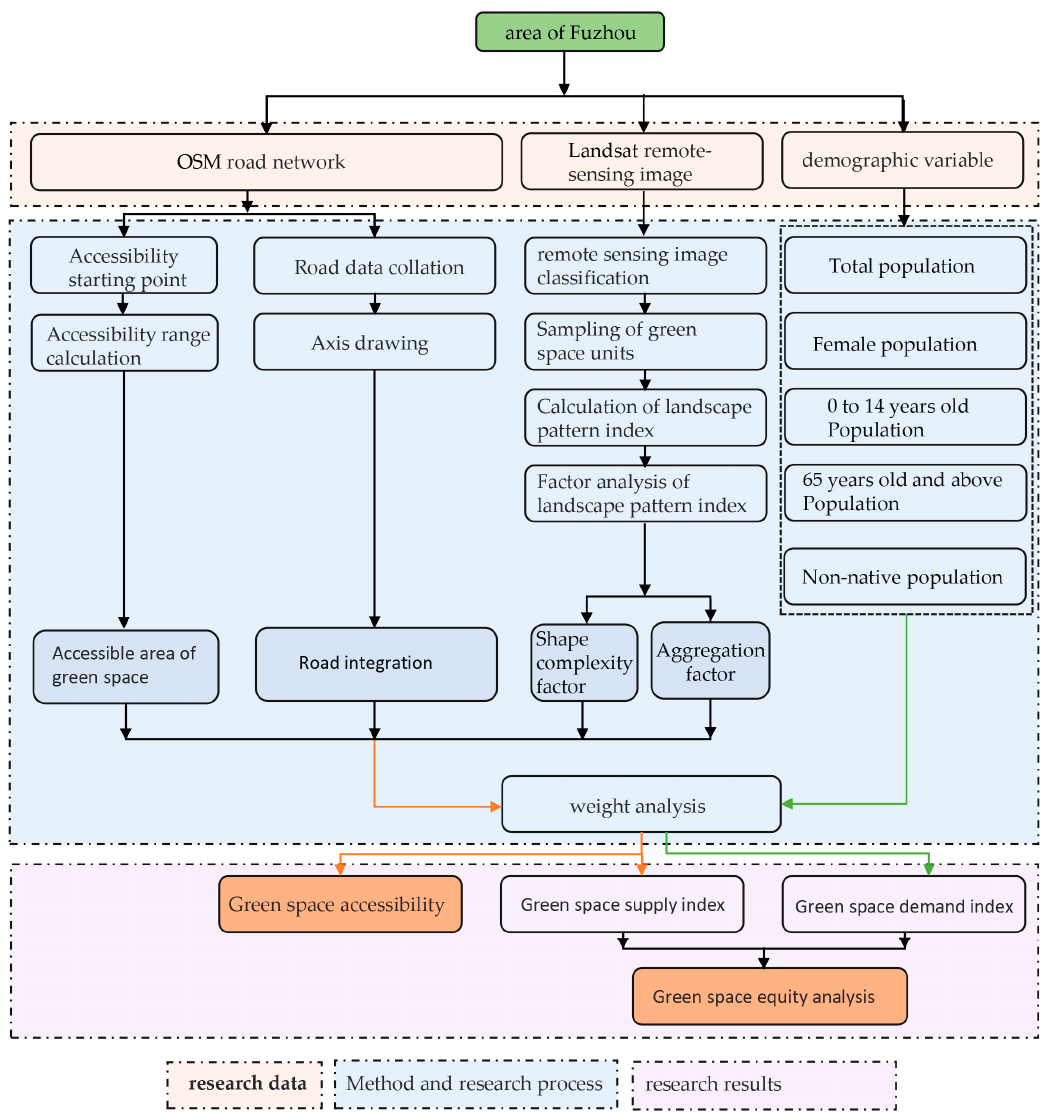
Figure 2. Research Framework.